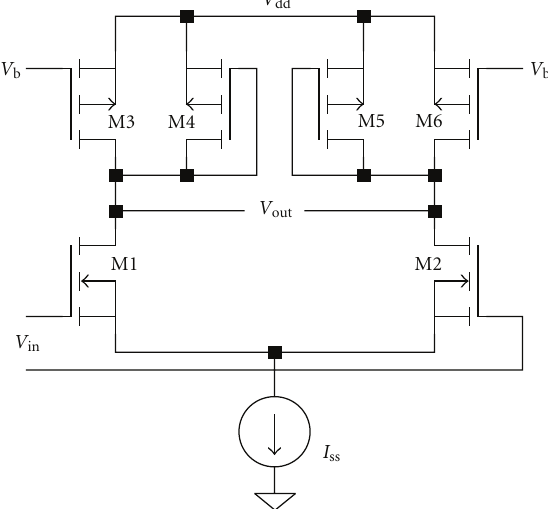
Figure 9: Di ff erential pair with current source in addition to diode- connected load.